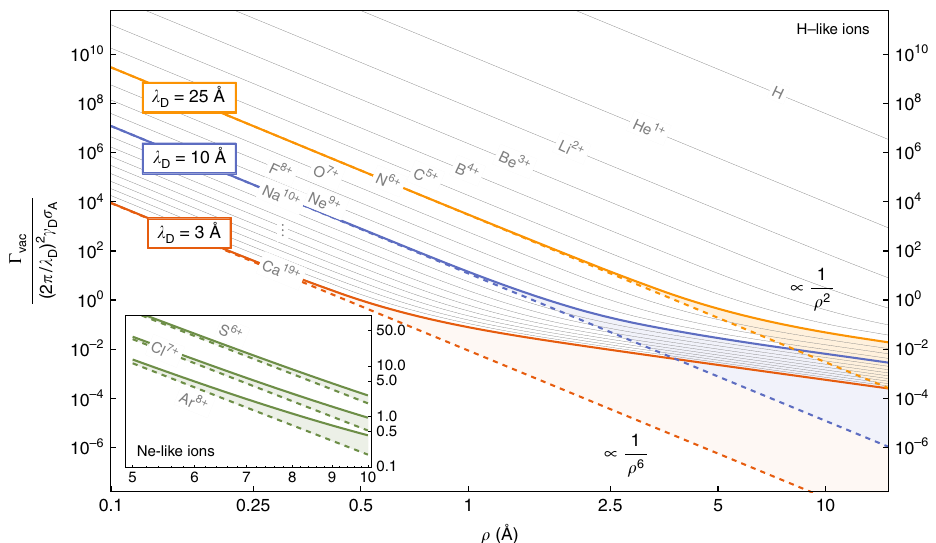
Fig. 2 Effect of retardation on interatomic Coulombic decay rate: Main plot: position-dependence of the interatomic Coulombic decay rate for arbitrary acceptor species and a variety of donors, as a function of their mutual separation ρ . Shown with thick solid lines are the rates for a selection of donor transition wavelengths λ D . In the near- fi eld (non-retarded) limit the rate is proportional to ρ − 6 (dashed straight lines), while in the far- fi eld (retarded) limit it becomes proportional to ρ − 2 , drastically enhancing the rate relative to that which is found if retardation is ignored. For reference we have shown as thin lines the ICD rates if the donor is taken to be a hydrogen-like ion undergoing a 2P 1/2 → 2S 1/2 transition 48 . The rates for the fi rst twenty such ions are shown (labels for Mg 11 + to K 18 + are replaced by ‘…’ for formatting reasons) demonstrating that, for example, an ICD process whose donor is a Na 10 + ( λ D = 10.05Å) ion will experience signi fi cant retardation at typical ICD distances (3 – 10 Å). Inset: Same axes as the main plot, instead displaying data relevant to the 1P° → 1S transition in selected neon-like